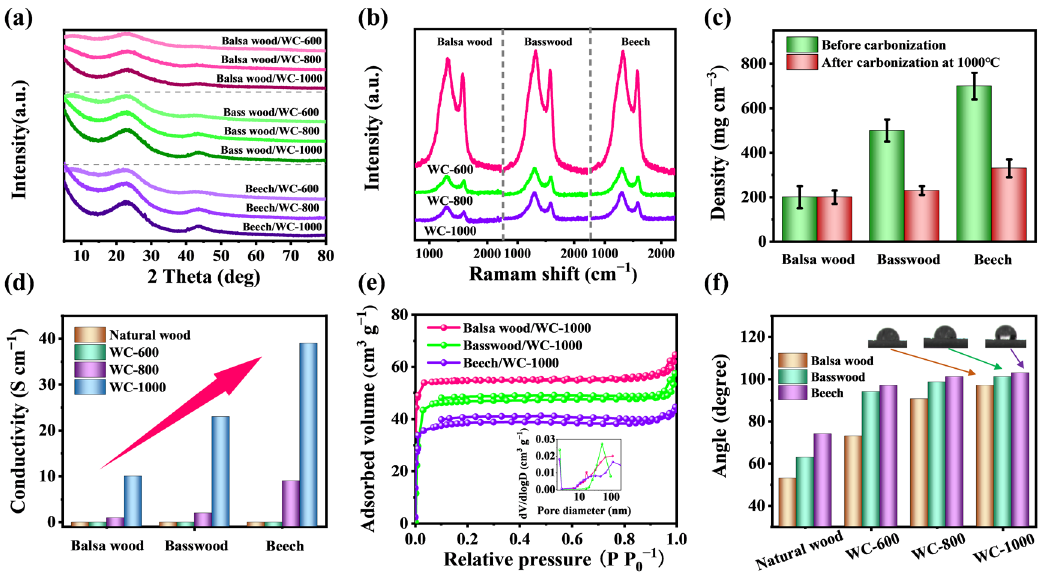
Figure 3. ( a ) XRD spectra and ( b ) Raman spectra of WC-600, CWF-800 and CWF-1000 of balsa wood, basswood and beech. ( c ) Densities and ( d ) electrical conductivities of samples. ( e ) N 2 adsorption- desorption isotherms and pore size distributions. ( f ) The contact angles of samples.